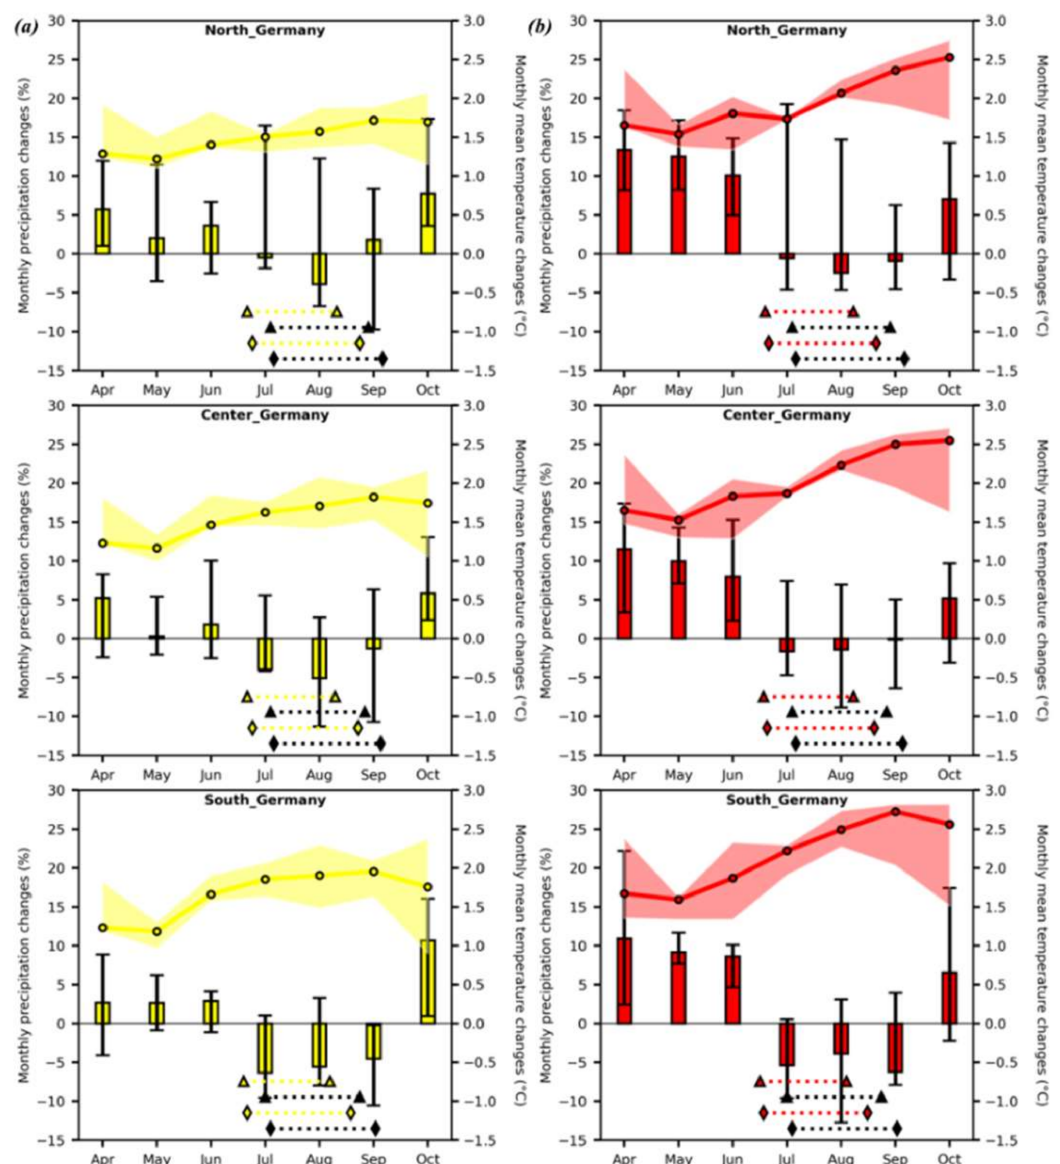
Figure 5. Projected monthly average temperature changes ( ◦ C) (in line plot) and precipitation sum changes (%) (in bar plot) over the growing season (April–October) for the future period (2041–2070) under ( a ) RCP4.5 (yellow) and ( b ) RCP8.5 (red) as compared to the baseline period (1976—2005) in northern (Latitude 52 ◦ –55 ◦ ), central (Latitude 50 ◦ –52 ◦ ) and southern (Latitude 47 ◦ –50 ◦ ) Germany. In the line plot, the lines represent regional mean values with the respective colour band indicating their 90% uncertainty range among RCMs. In the bar plot, bars indicate the regional mean values with the respective error bars indicating their 90% uncertainty range among RCMs. The regional mean flowering stage and veraison stage are also shown for Müller-Thurgau (triangular) and Riesling (diamond). Note that for the same variety in each subplot, the phenology symbols occurring earlier correspond to the flowering stage, and the next symbol is the veraison stage. The phenology symbols with black, yellow and red are for the baseline, RCP4.5 and RCP8.5,